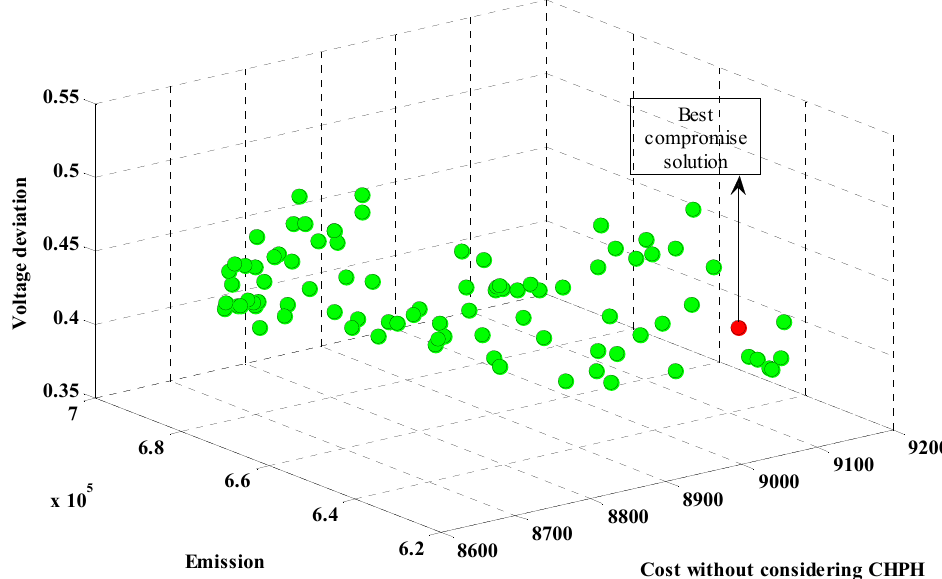
Figure 10. Pareto front for cost considering strategy 1, emission and voltage deviation objective functions.